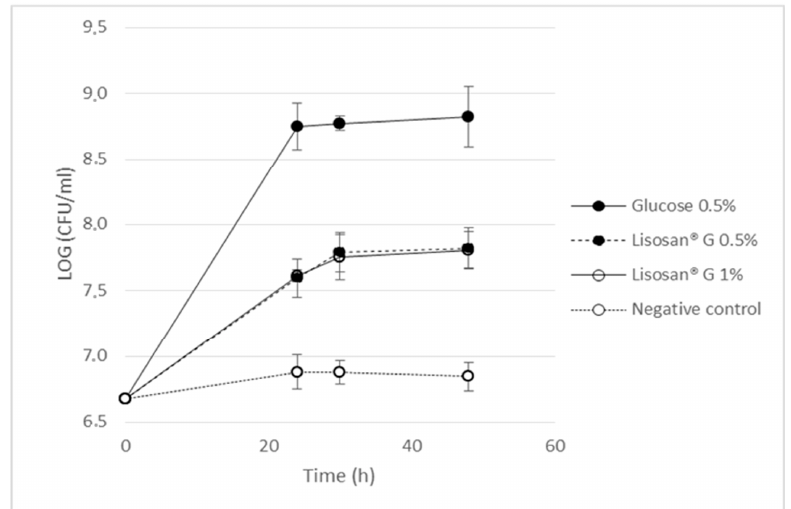
Figure 7. Ability of Lisosan ® G (LG 1 ) tested at different concentration (0.5 and 1%) in stimulating the growth of L. reuteri